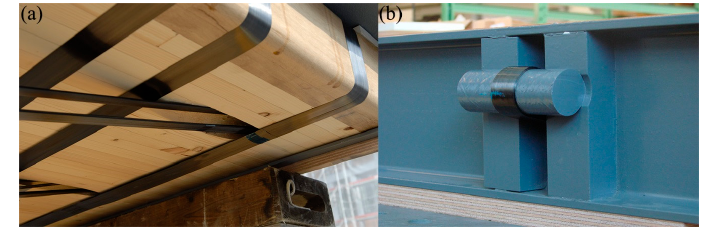
Figure 24. ( a ) CFRP non-laminated strip-loop cable and ( b ) pin-loaded anchorage (photo credit: Urs Meier).